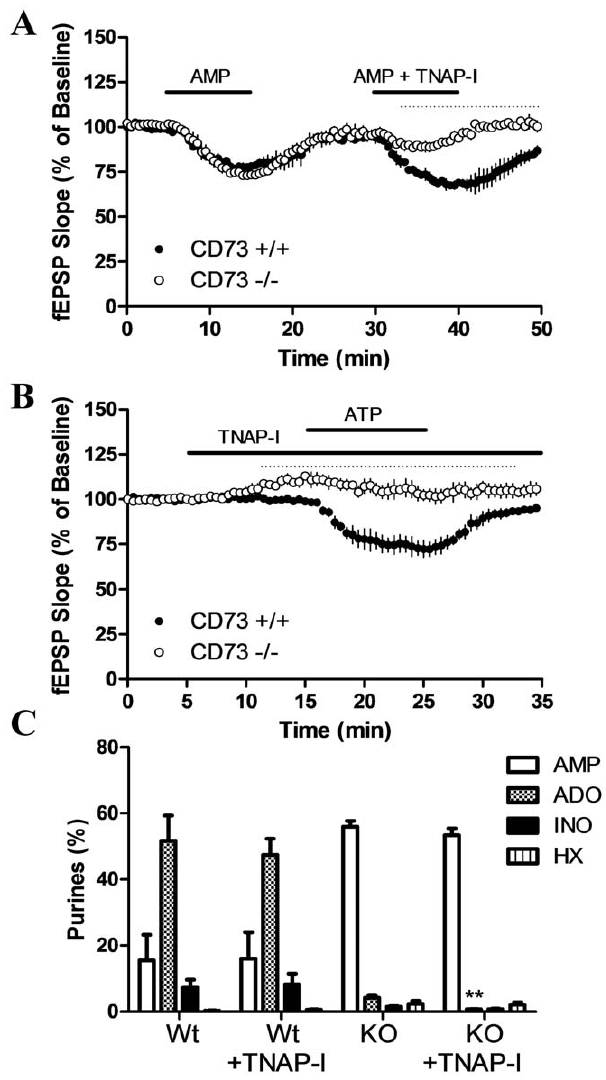
Figure 7. Inhibition of fEPSPs by AMP or ATP is reduced by TNAP-I selectively in CD73 2 / 2 slices. (a) Hippocampal slices from CD73 + / + and CD73 2 / 2 mice were superfused with 10 m M AMP as indicated by the horizontal bar. After 15 min recovery, slices were superfused with 10 m M AMP plus 10 m M TNAP-I as indicated by the second horizontal bar. n =3 CD73 + / + and 3 CD73 2 / 2 . Significant differences between genotypes are indicated by dashed lines; p , 0.05; unpaired t -tests. (b) Hippocampal slices from CD73 + / + and CD73 2 / 2 mice were superfused with 10 m M TNAP-I and, after 10 min, with 10 m M ATP as indicated by the horizontal bars. n =3 CD73 + / + and 3 CD73 2 / 2 . Significant differences between genotypes are indicated by dashed lines; p , 0.05; unpaired t -tests. (c) Inhibition of metabolism of [ 14 C]AMP to [ 14 C]adenosine, [ 14 C]inosine and [ 14 C]hypoxanthine by TNAP-I was determined using membrane preparations from cerebral cortices. n =4 CD73 + / + and 4 CD73 2 / 2 . * p , 0.05, relative to absence of TNAP-I; unpaired t -test. Ado, adenosine; Ino, inosine; HX,